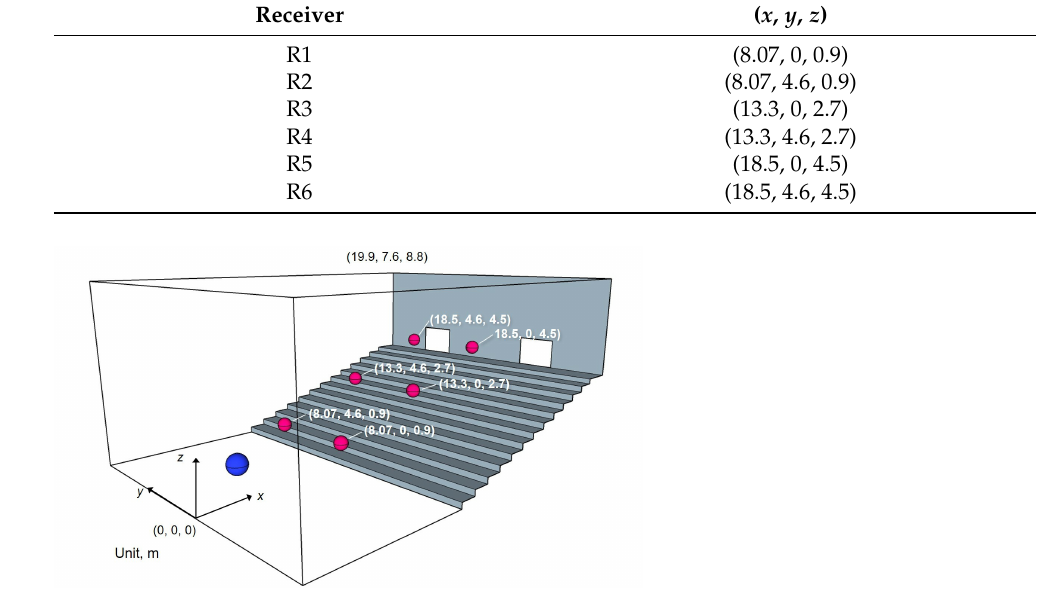
Figure 6. Auditorium model for demonstrating binaural auralization application. Blue and magenta spheres respectively represent a source point and receiving points.